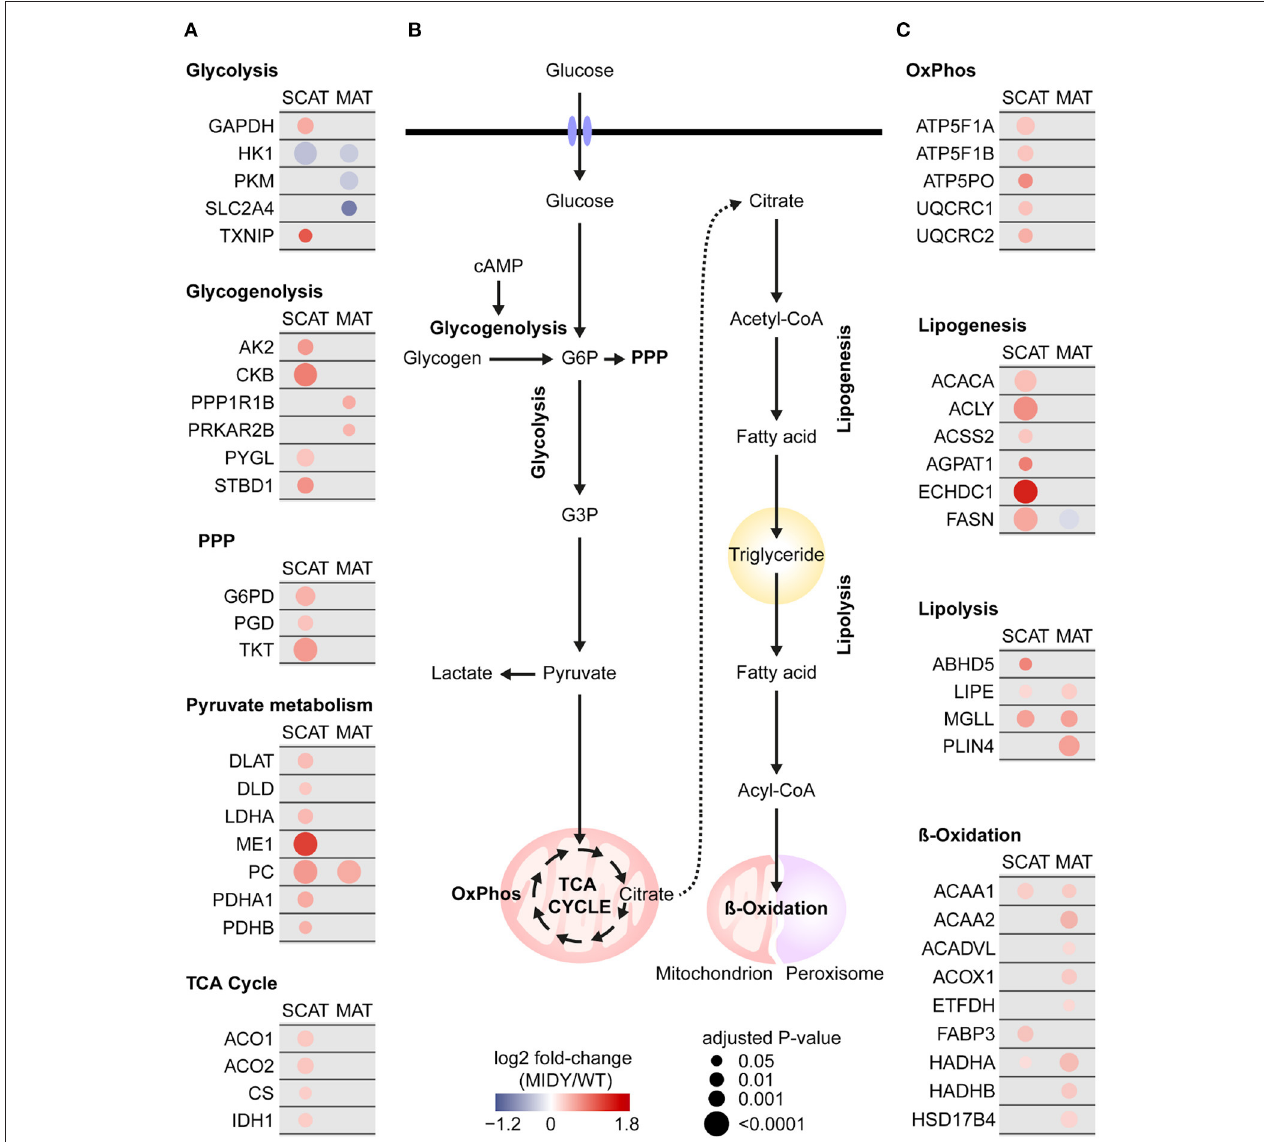
FIGURE 4 | Impaired carbohydrate and fat metabolism in MIDY SCAT and MAT. (A,C) Protein abundance alterations in MIDY compared to WT are color coded and shown as log2 fold-change of MIDY/WT. Red circles represent an increased abundance and blue a decreased abundance in MIDY, respectively. Circle size correlates with Benjamini-Hochberg-adjusted P -value. Only proteins with an adjusted P < 0.05 in at least one tissue depot are shown. Proteins that were not significant or not detected in that tissue depot are grayed out. (B) Schematic representation of glucose and fat metabolism in adipose tissue. G6P, glucose-6-phosphate; G3P, glyceraldehyde-3-phosphate; cAMP, cyclic adenosine monophosphate; PPP, pentose phosphate pathway; OxPhos, oxidative phosphorylation.